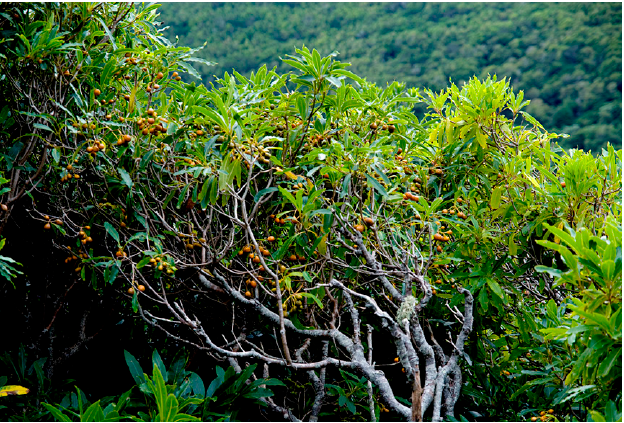
Figure 1. Victoria box tree from Azores (adapted from SIARAM – Governo dos Açores) [6].